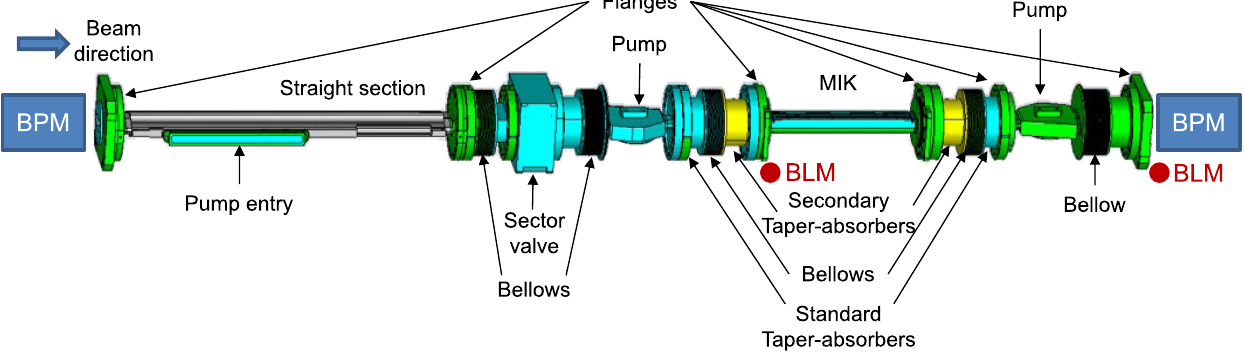
FIG. 7. MIK section. The MIK is installed in a short straight section of the storage ring, which starts and ends with a beam position monitor (blue squares). A pair of taper/absorber chambers, upstream and downstream of the MIK, adapt the physical apertures of the standard vacuum chamber and protect the MIK from the synchrotron radiation. Two beam loss monitors (red dots) surround the MIK for radiation safety purposes. The ultrahigh vacuum is guaranteed by a triplet of